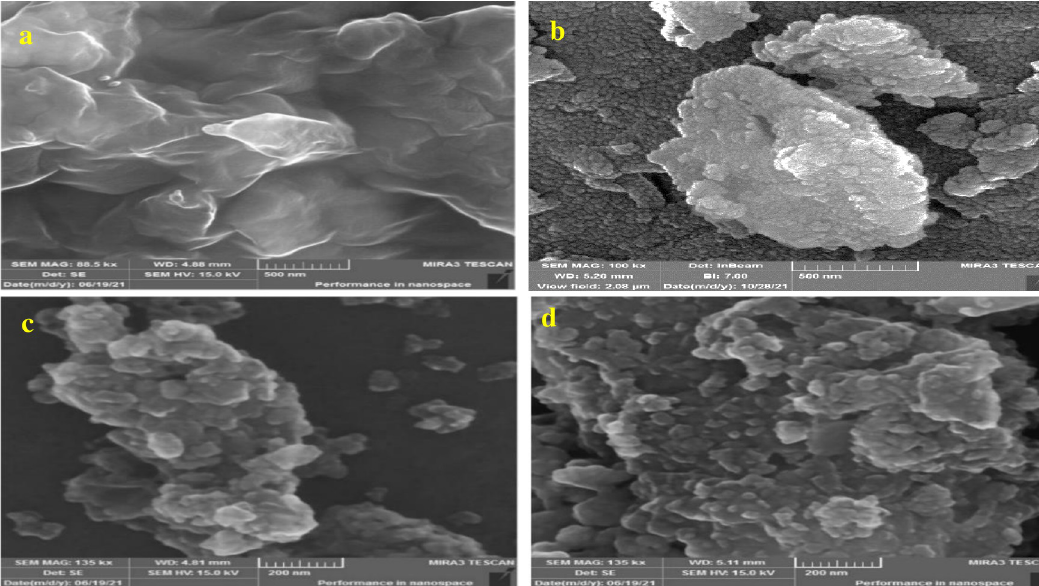
Fig 3. FESEM images of (a) Imine before adsorption (88.5 kx, 500 nm), (b) after adsorption of Cu(II) ion (100 kx, 500 nm), (c) after adsorption of Zn(II) ion, (135 kx, 200 nm) and (d) after adsorption of Cr(III) ion (135 kx, 200 nm).